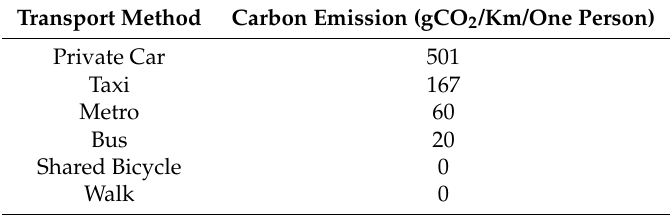
Table 1. Carbon emissions of different transport methods